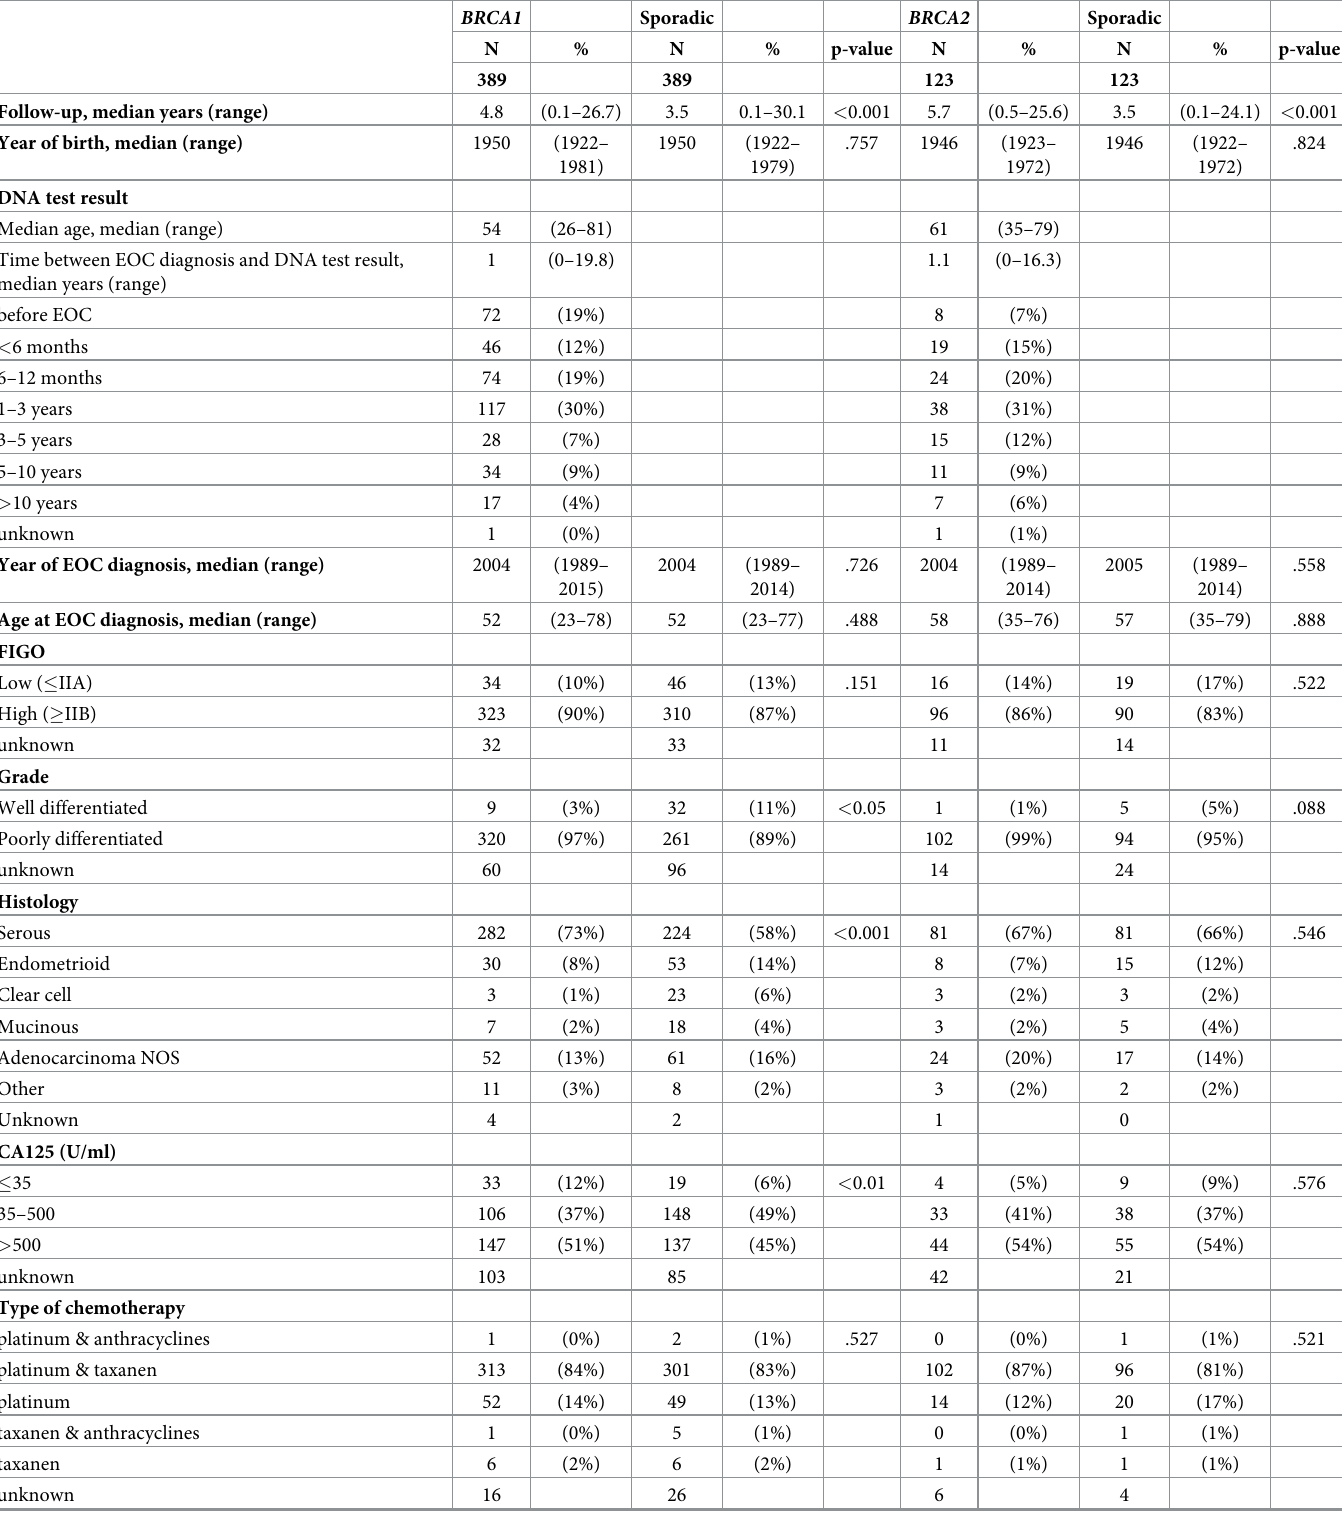
Table 1. Patient and tumor